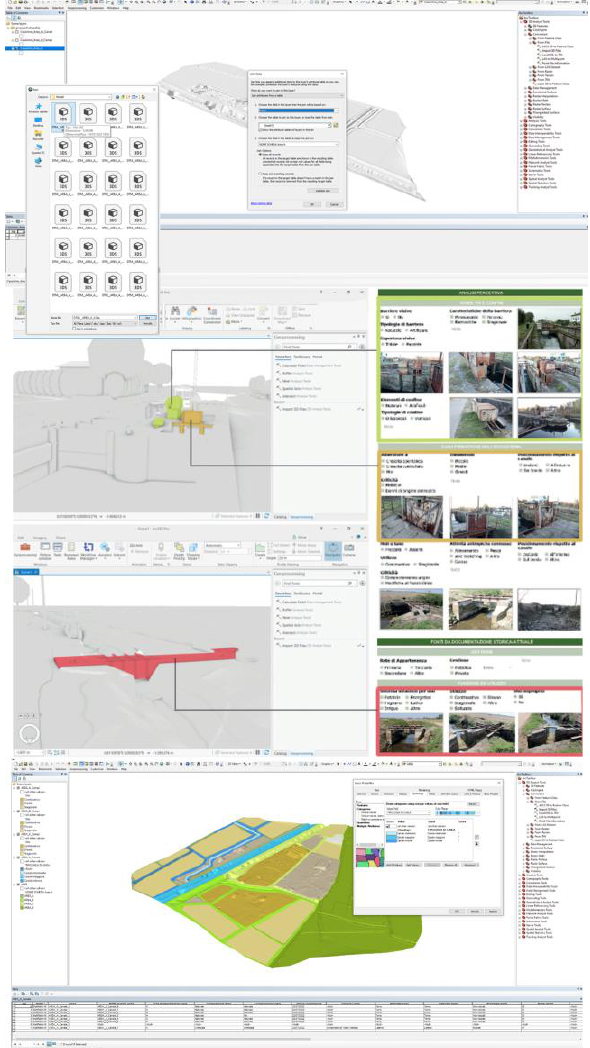
Figure 5 . The census was implemented as a relational database and exportable as a tabular file; each card is associated with a unique code that represents the corresponding